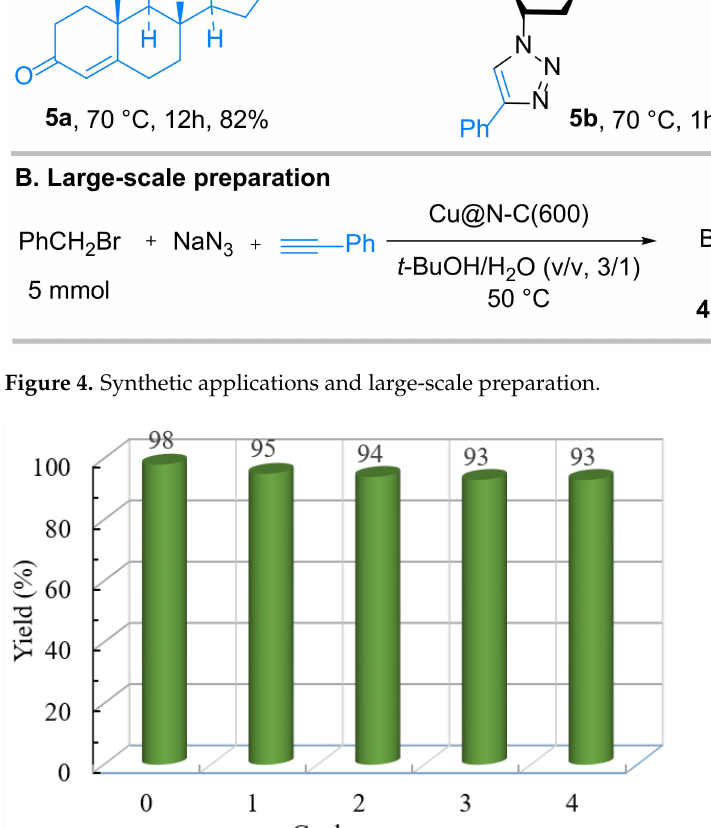
Table 4. The Cu leaching of Cu@N-C(600)